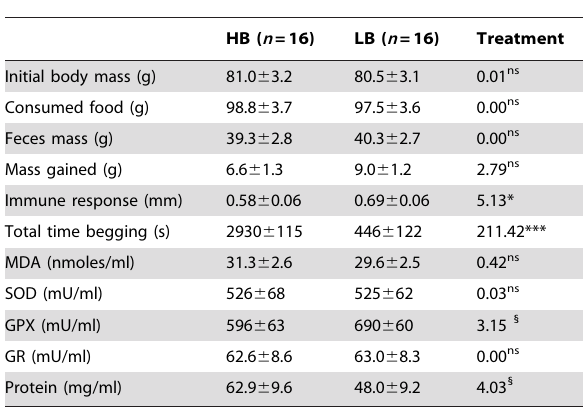
Table 1. Mean 6 SE for each variable measured in the study, and the effects of Treatment, controlling for Nest (random factor) and